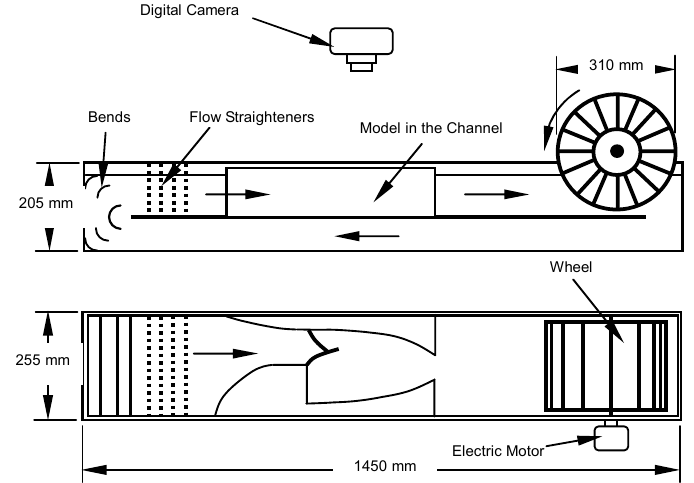
Figure 3: Schematic of the circulating water channel & the flow model.